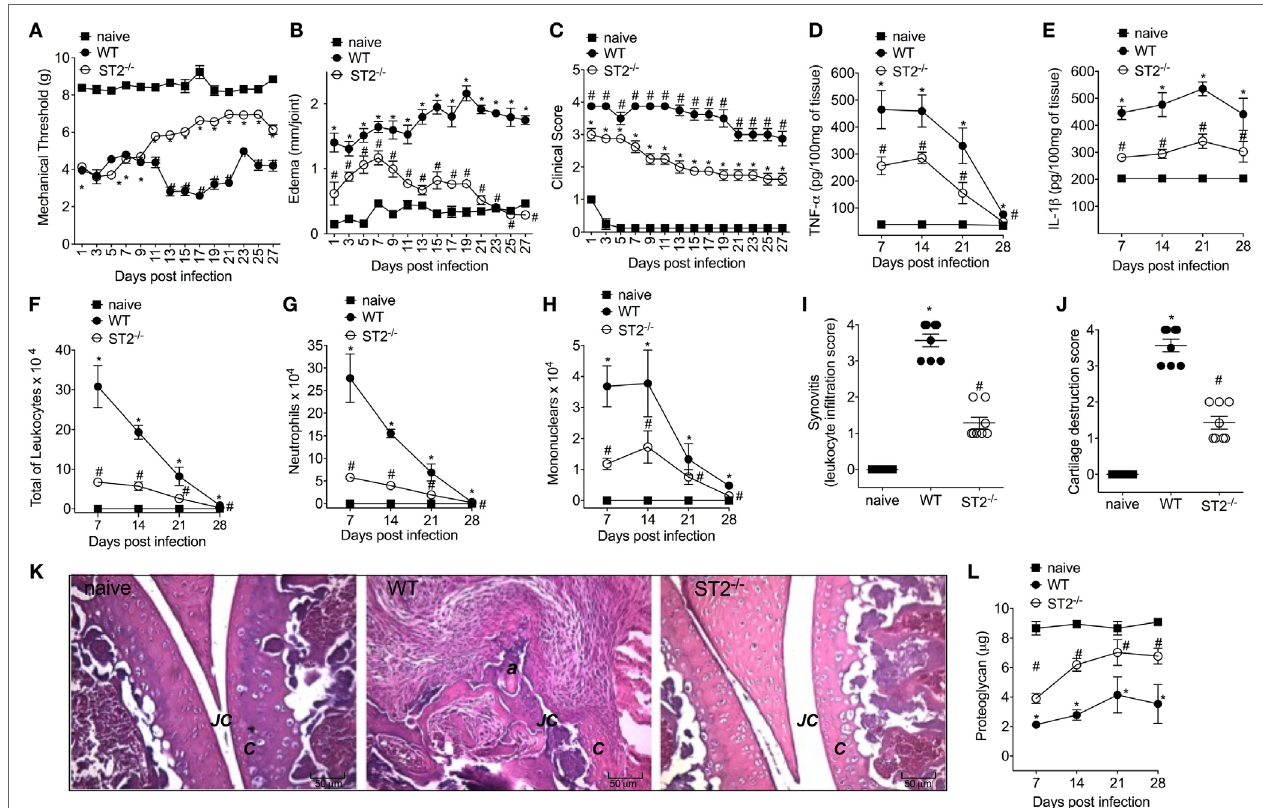
FigUre 2 | ST2 deficiency ameliorates Staphylococcus aureus -induced septic arthritis. S. aureus or saline was injected in the femur-tibial joint of wild-type (WT) and ST2 − / − mice. (a) Mechanical hyperalgesia, (B) articular edema, and (c) clinical score were evaluated over 27 days post-infection. Knee joints were collected and processed to determine the levels of (D) TNF- α and (e) IL-1 β by ELISA determined at days 7–28 days post-infection. (F) Total leukocytes, (g) neutrophil, and ( h) mononuclear recruitment to the knee joint were determined at 7–28 days post-infection. Knee joint samples were collected at the 28th day post-infection for histological analysis by hematoxylin/eosin stained slices to determine: (i) synovitis score (intensity: 1–4) and (J) cartilage destruction score (intensity: 1–4). (K) Representative images of knee joints at 28 post-infection in original magnification × 10. The letter a indicates a heavily inflamed joint with cartilage destruction and pannus formation. (F) Proteoglycan content in patella determined at 7–28 days post-infection. For inflammatory parameters and proteoglycan content: n = 6 per group per in vivo experiment, representative of two independent experiments. * P < 0.05 vs naïve mice group, # P < 0.05 vs WT mice group (a–h,l) .